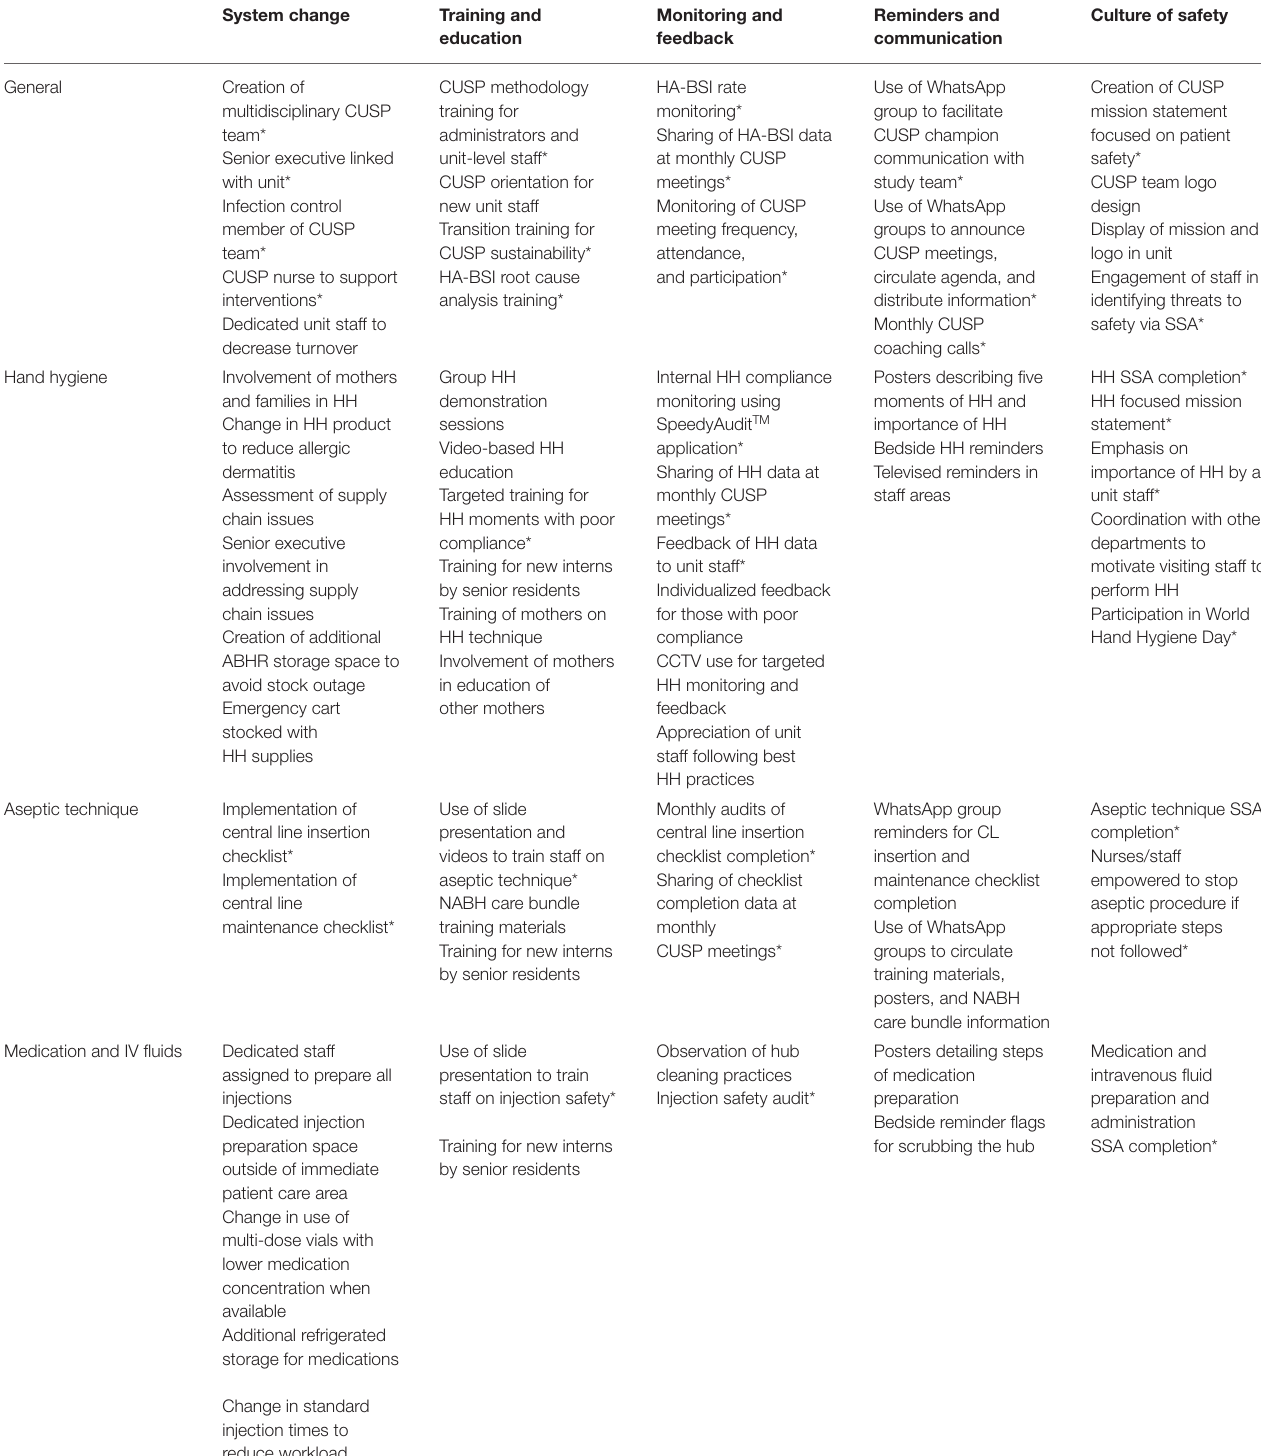
TABLE 1 | CUSP interventions, general and by focus area, categorized by the five elements of the WHO multimodal IPC improvement